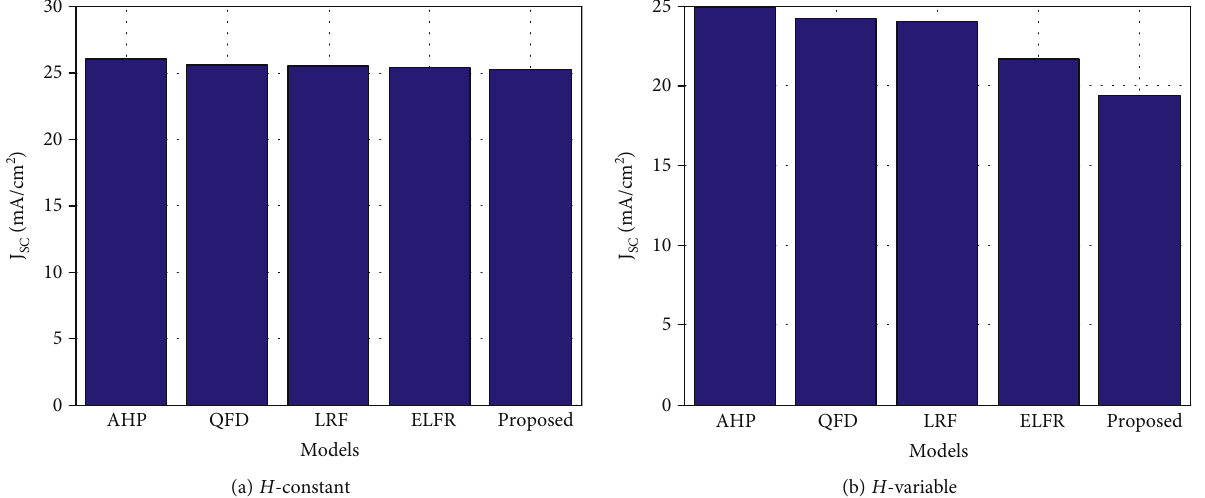
Figure 3: Short circuit